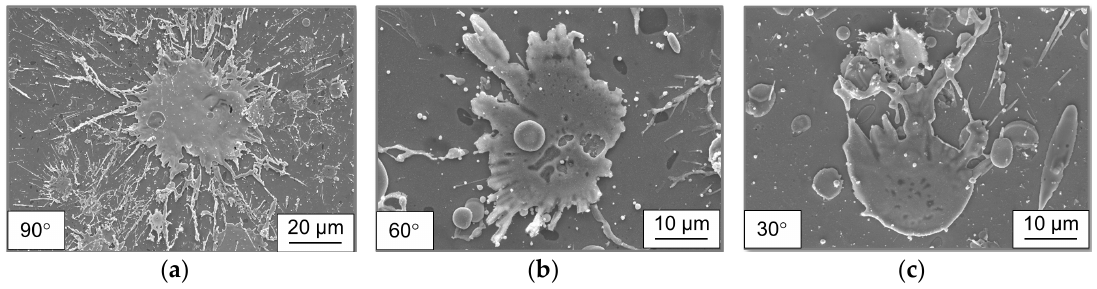
Figure 5. Electron microscopy showing the splashing of spray particles deposited at different spray angles: ( a ) 90°; ( b ) 60°; ( c ) 30°.